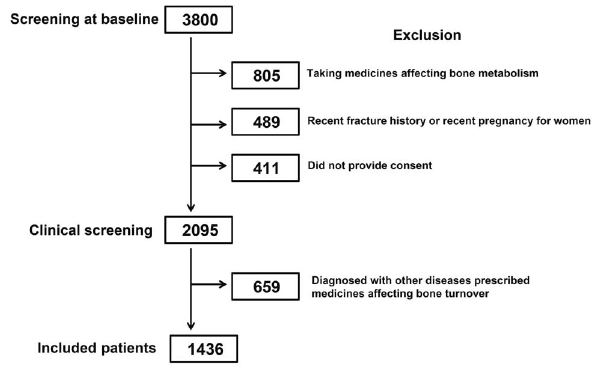
Figure 1. Subject screening and